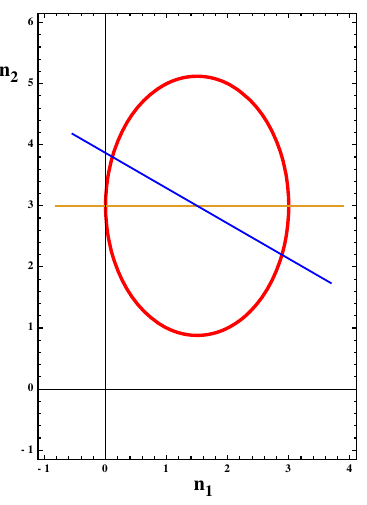
Figure 5 . The Minkowski solutions for (cid:11) 1 = 1 and (cid:11) 2 = 2 are described by an ellipse in ( n 1 ; n 2 ) space. Lines passing through the center of the ellipse connect antipodal points, as illustrated with two